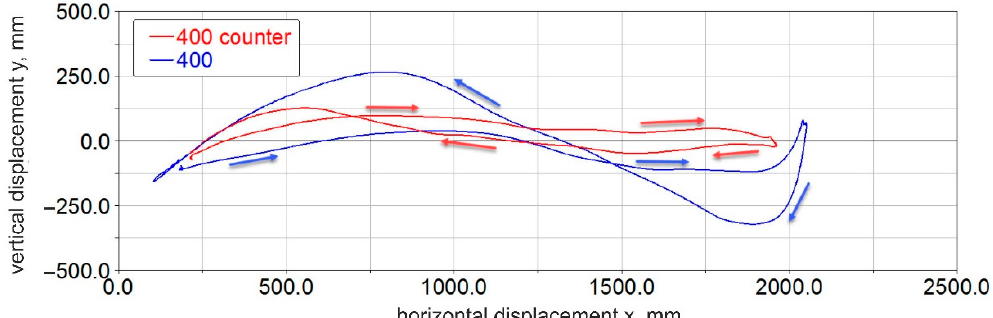
Figure 12. Manipulator’s effector trajectories for a velocity of 300 mm/s.